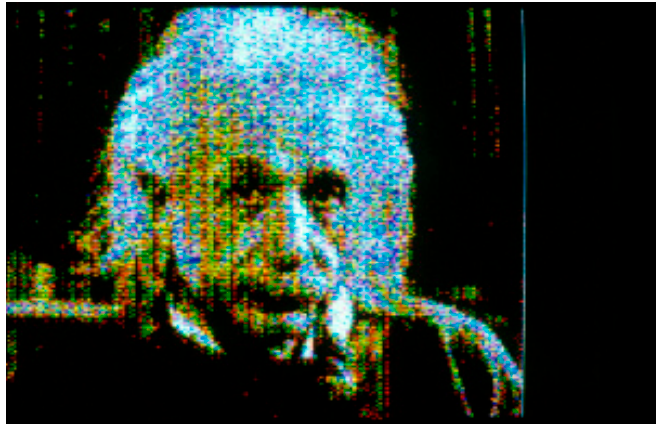
Figure 3. Unnamed image from Ostoja’s slide collection. Published with permission. Image courtesy of the State Library of South Australia. SLSA: PRG919/22/404.